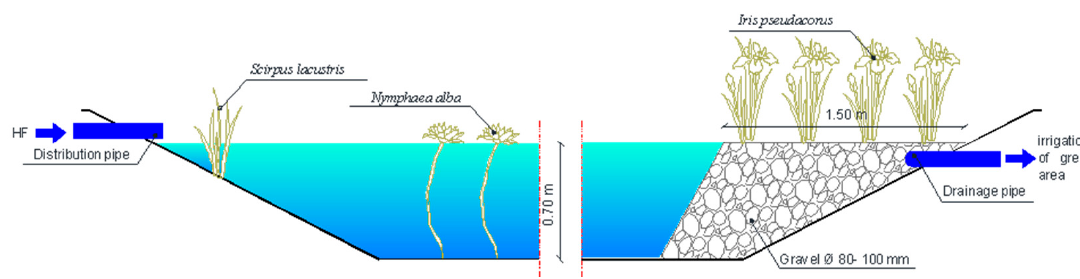
Figure 4. Section of the free surface flow unit (FSF) CW bed located at the Marabino winery.